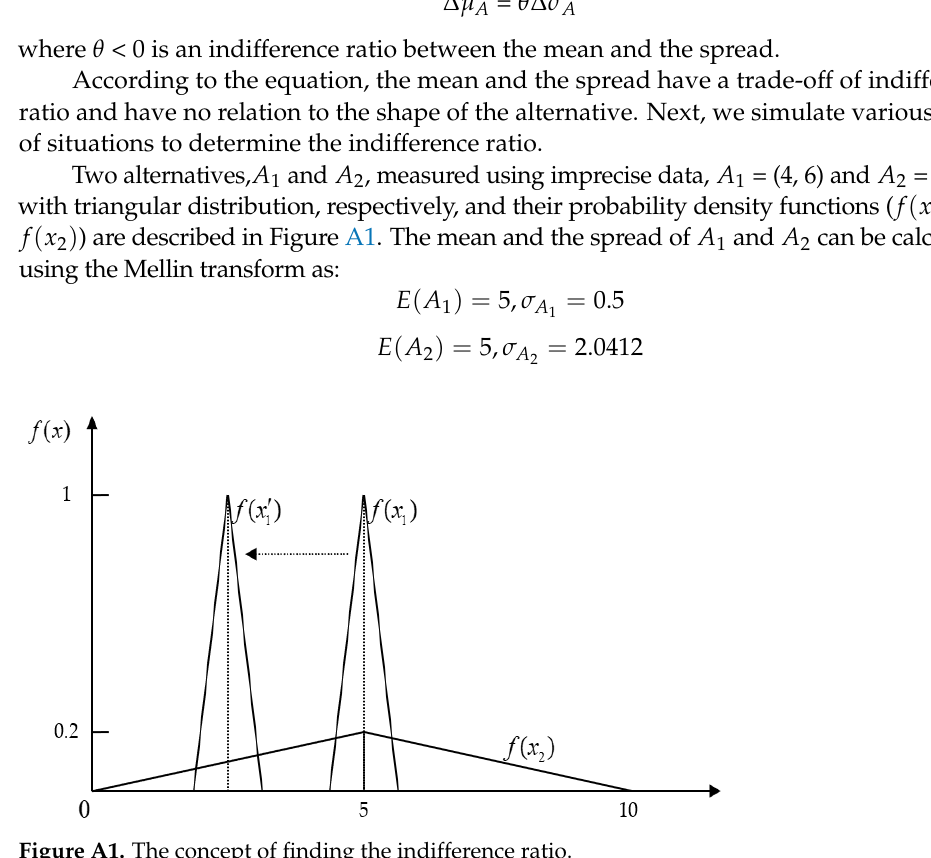
Figure A2. The trade-off result where